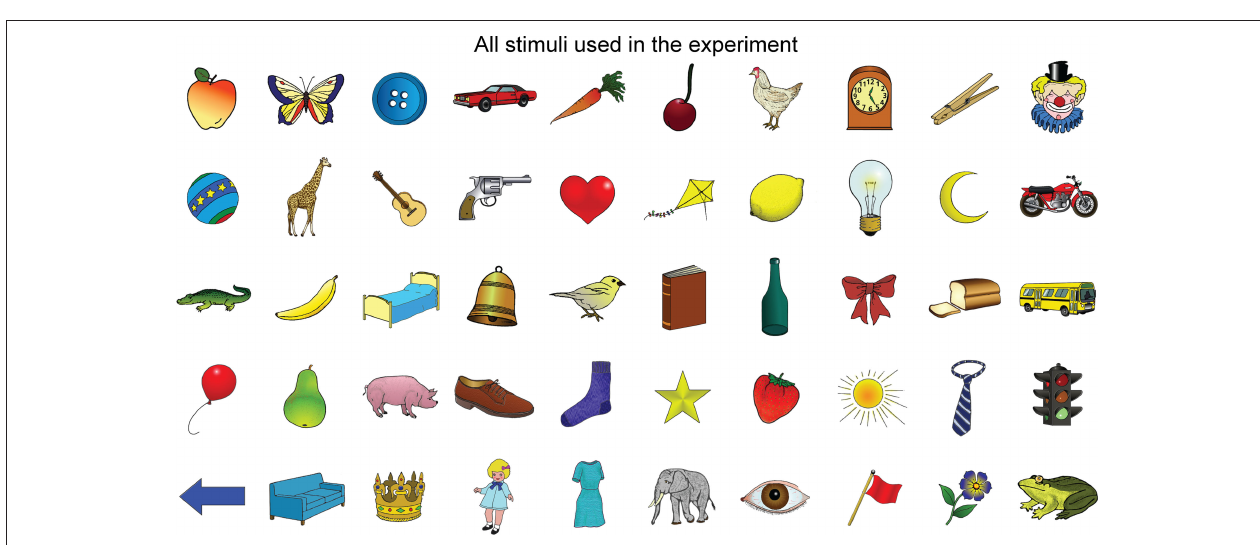
Figure S1 | We selected 50 line drawn objects from a series of 260 objects created by rossion and Pourtois (2004). All objects used in our experiment are depicted in this